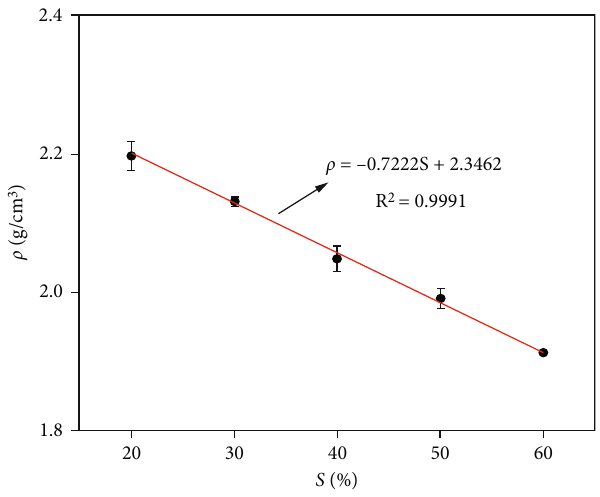
Figure 5: The density ρ with S